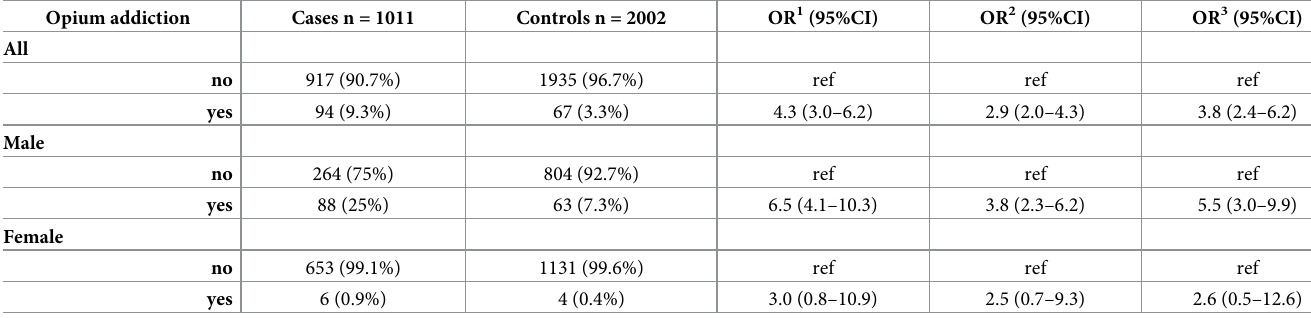
Odds ratios are obtained by multivariate logistic regression. OR 1 are adjusted for age and sex; OR 2 are adjusted for OR 1 and additionally for smoking; OR 3 are adjusted for OR 2 and additionally for the presence of hypertension, dyslipidaemia, diabetes and BMI.